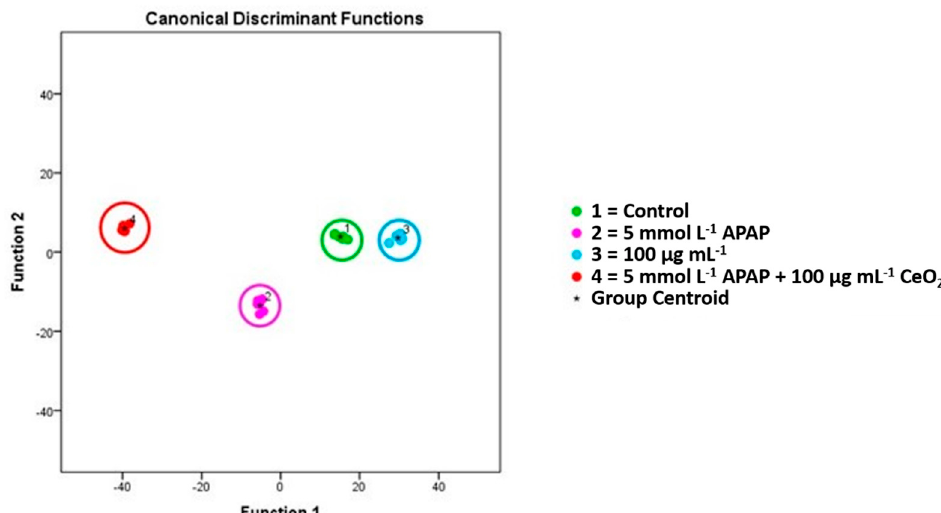
Figure 10. Metabolic changes of HuH-7 cells after treatment with APAP (5 mmol L − 1 ), CeO 2 NPs (100 µg mL − 1 ) and APAP (5 mmol L − 1 ) plus CeO 2 NPs (100 µg mL − 1 ). The diagram shows the values of the discriminant scores obtained from Fisher’s discriminant analysis of 24 HuH-7 samples for 78 principal compounds, which were selected to discriminate between cells treated with APAP (5 mmol L − 1 ), CeO 2 NPs (100 µg mL − 1 ) and APAP (5 mmol L − 1 ) plus CeO 2 NPs (100 µg mL − 1 ). All four groups can be well separated from each other. The model was evaluated using the “leave-one-out” formalism (100% correct grouping of ungrouped cases).